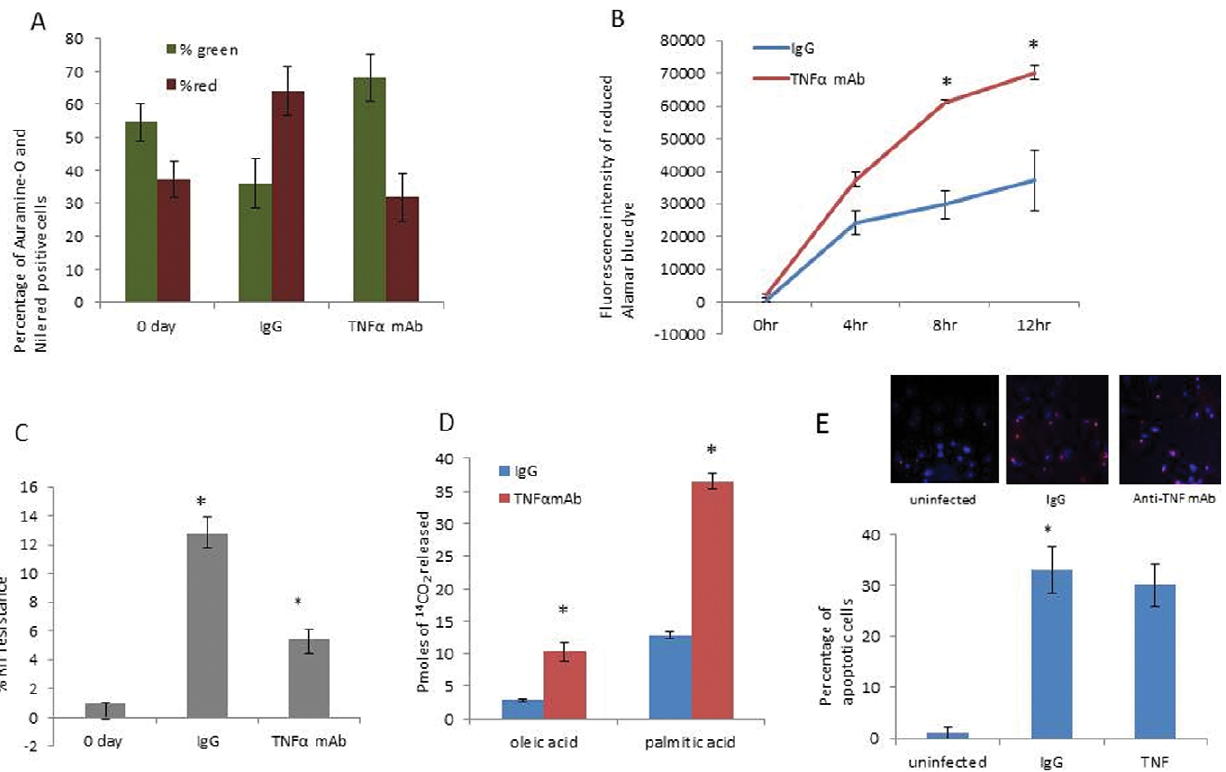
Figure 5. Addition of anti-TNF a monoclonal antibody caused reactivation of dormant Mtb . ( A ) Auramine-O and Nile red staining of WT Mtb from IgG and anti-TNF a antibody treated granulomas. ( B ) Alamar Blue readouts at different time intervals when WT Mtb cells from granulomas treated with anti-TNF- a antibody or control IgG, were incubated with Alamar blue dye. (data of one representative data set has been displayed.) ( C ) WT Mtb cells from granulomas treated with anti-TNF- a antibody had a lower antibiotic resistance as compared to WT Mtb cells from control IgG treated granulomas. ( D ) Mtb cells from granulomas treated with anti-TNF a antibody catabolized fatty acids at a higher rate than Mtb from control IgG treated granuloma. P values were calculated using students t test. p , 0.05 for metabolism of oleic and palmitic acid for Mtb from anti-TNF- a antibody treated granuloma compared to Mtb from IgG treated granuloma. (E) Infection of hPBMCs resulted in Apoptosis of these cells. Data are presented as mean + / 2 SEM from 3 experiments. P values were calculated using students t test. * p ,